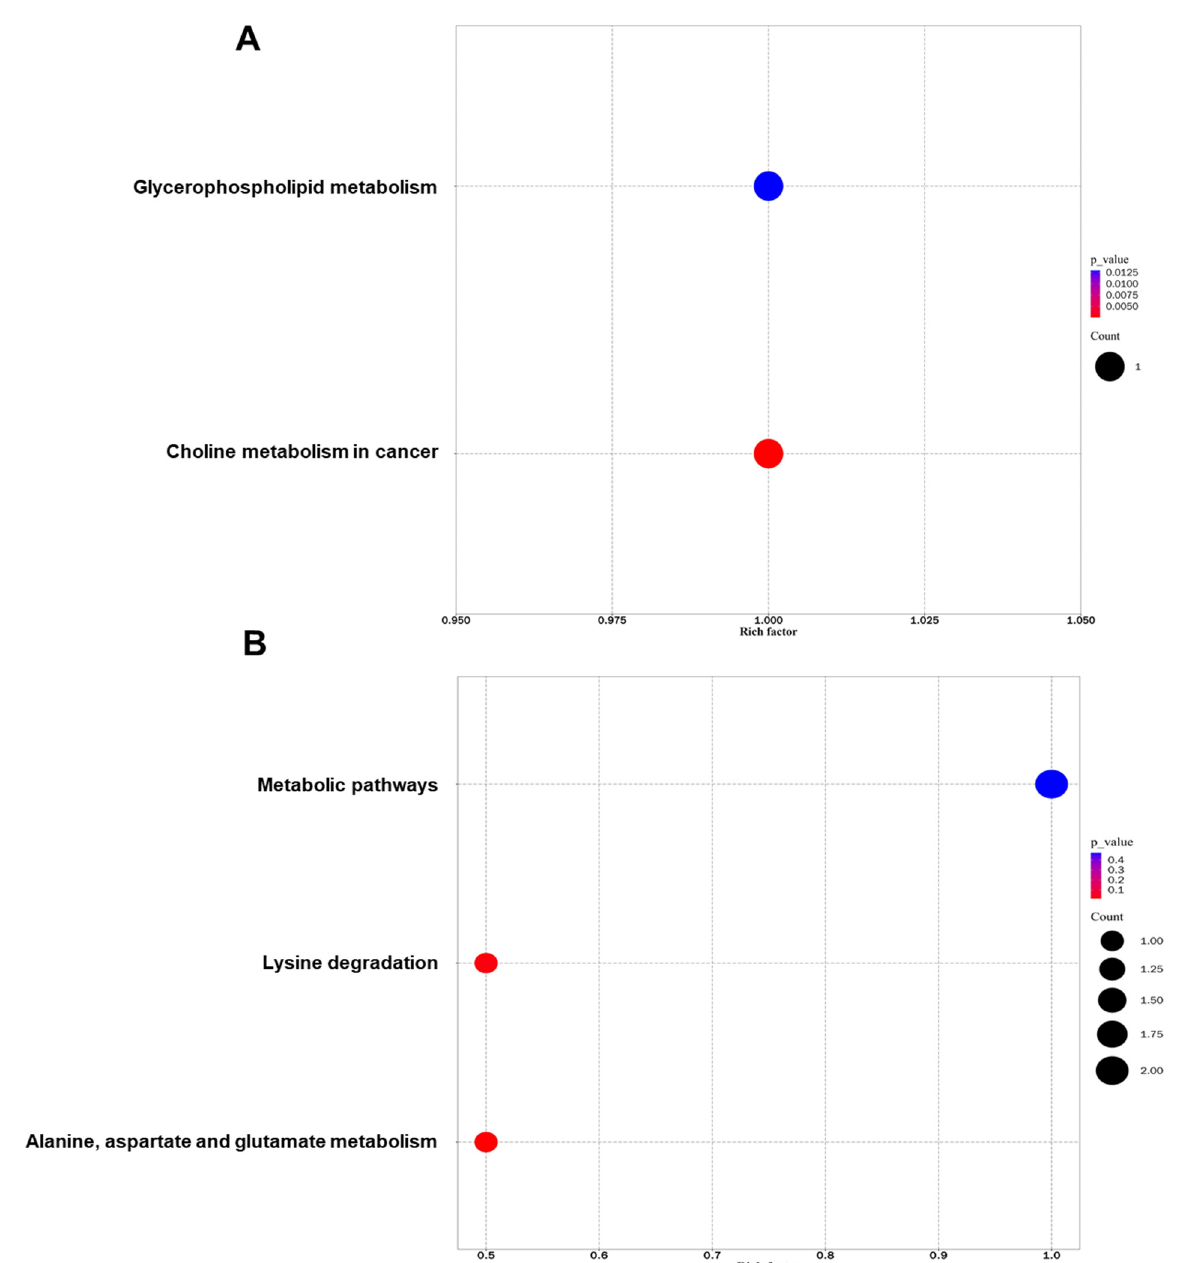
Figure 6. KEGG analysis of differential metabolites between HS and NHS groups. ( A ) Illustration of differential metabolite-enriched pathways in the positive ion mode. The color scale in the right of the bubble image represents gradual decrease of p-value from blue to red. Metabolic pathways are displayed in the left of the bubble image. ( B ) Illustration of differential metabolite-enriched pathways in the positive ion mode. The color scale in the right of the bubble image represents gradual decrease of p -value from blue to red. Metabolic pathways are displayed in the left of the bubble image.